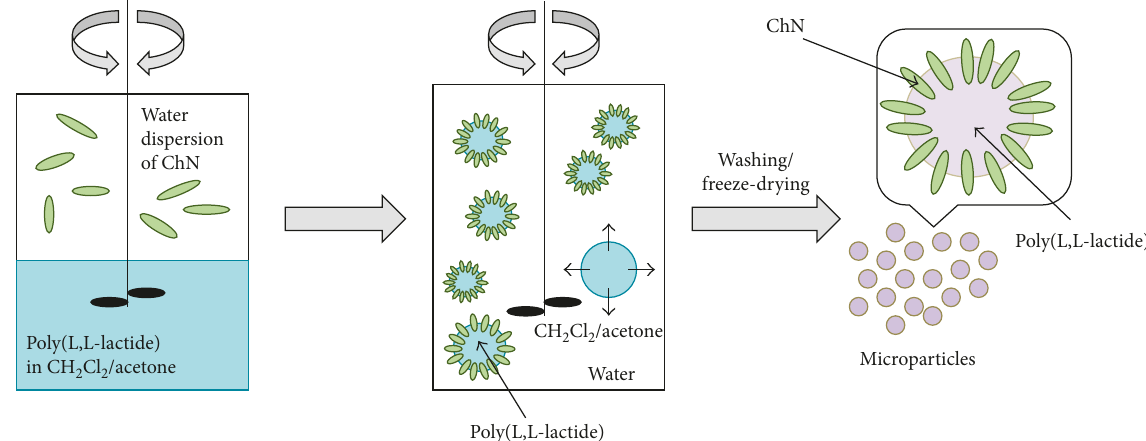
Figure 1: Scheme of PLLA-ChN core-shell microparticles preparation via Pickering oil/water emulsion solvent evaporation